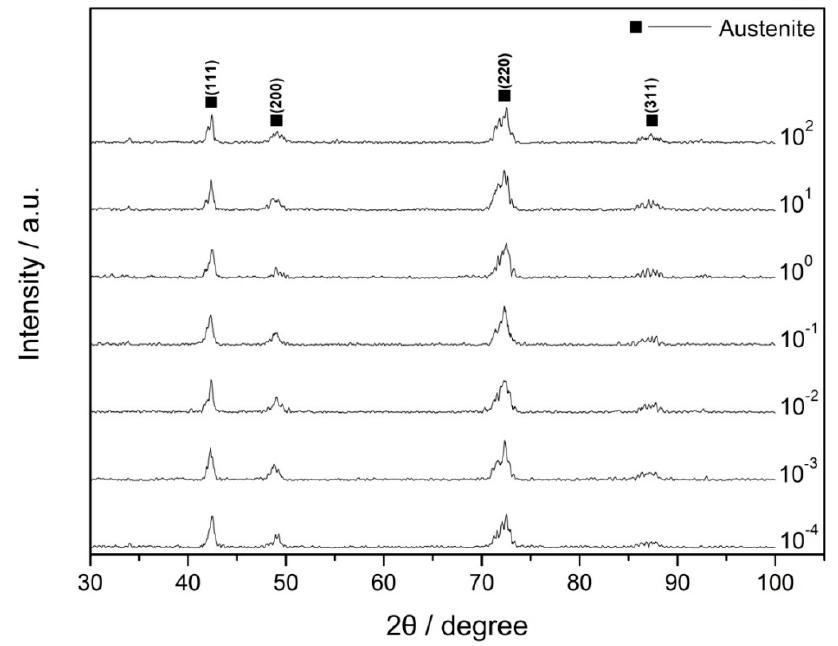
Figure 3. The optical metallographs of Fe–30Mn–9Al–1C steel deformed at strain rates of 10 − 4 s − 1 ( a ), 10 − 3 s − 1 ( b ), 10 − 2 s − 1 ( c ), 10 − 1 s − 1 ( d ), 10 0 s − 1 ( e ), 10 1 s − 1 ( f ), and 10 2 s − 1 ( g ). Figure 4. The detecting position was consistent with that in the metallographic observation experiment. The austenitic matrix of steel was stable and did not decompose due to the influence of the applied strain. From the XRD results, the specimens were austenitic single-phase structures at all strain rates. The intergranular particles found in metallographic observations might not be detected by XRD due to their low content. Because of the influence of residual stress, the austenite diffraction peaks were somewhat broadened.